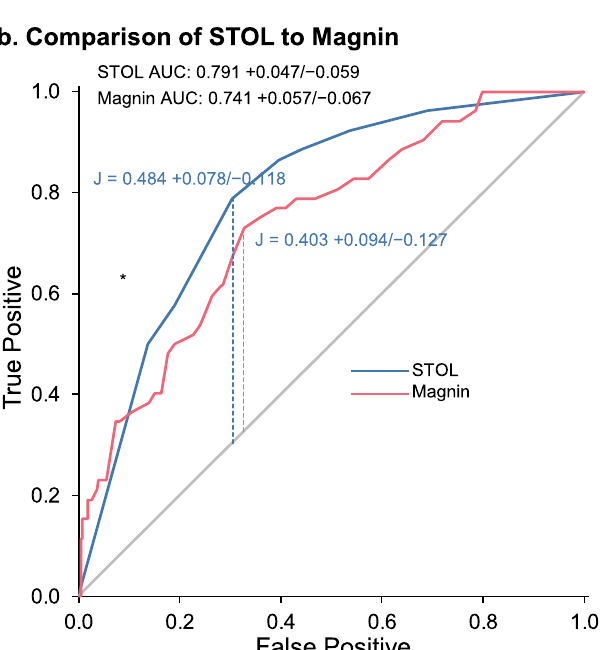
Figure 2. ROC analysis of STOL vs each and all outcomes, and ROC analysis comparing successful trial of labor vs CS for STOL and for Magnin scores. ( a ) ROC corresponding to multinomial logistic model of STOL vs each outcome (Fig. 1b). Both micro and macro mean AUCs are calculated, as are Youden’s J for each. Confidence intervals could not be calculated due to the bootsrap of the highly unbalanced data set not being stable. A larger sample size could compensate. ( b ) Comparison of STOL vs. Magnin in predicting CS outcome (excluding scheduled CS) vs successful trial of labor. Three methods of evaluating curve strength (AUC, Youden’s J, and Matthews correlation coefficient [MCC]) determined STOL to be superior to Magnin, as described in the text. The 95% CIs are from a nonparametric bootstrap of each model, followed by calculation of differences of AUC, J, and